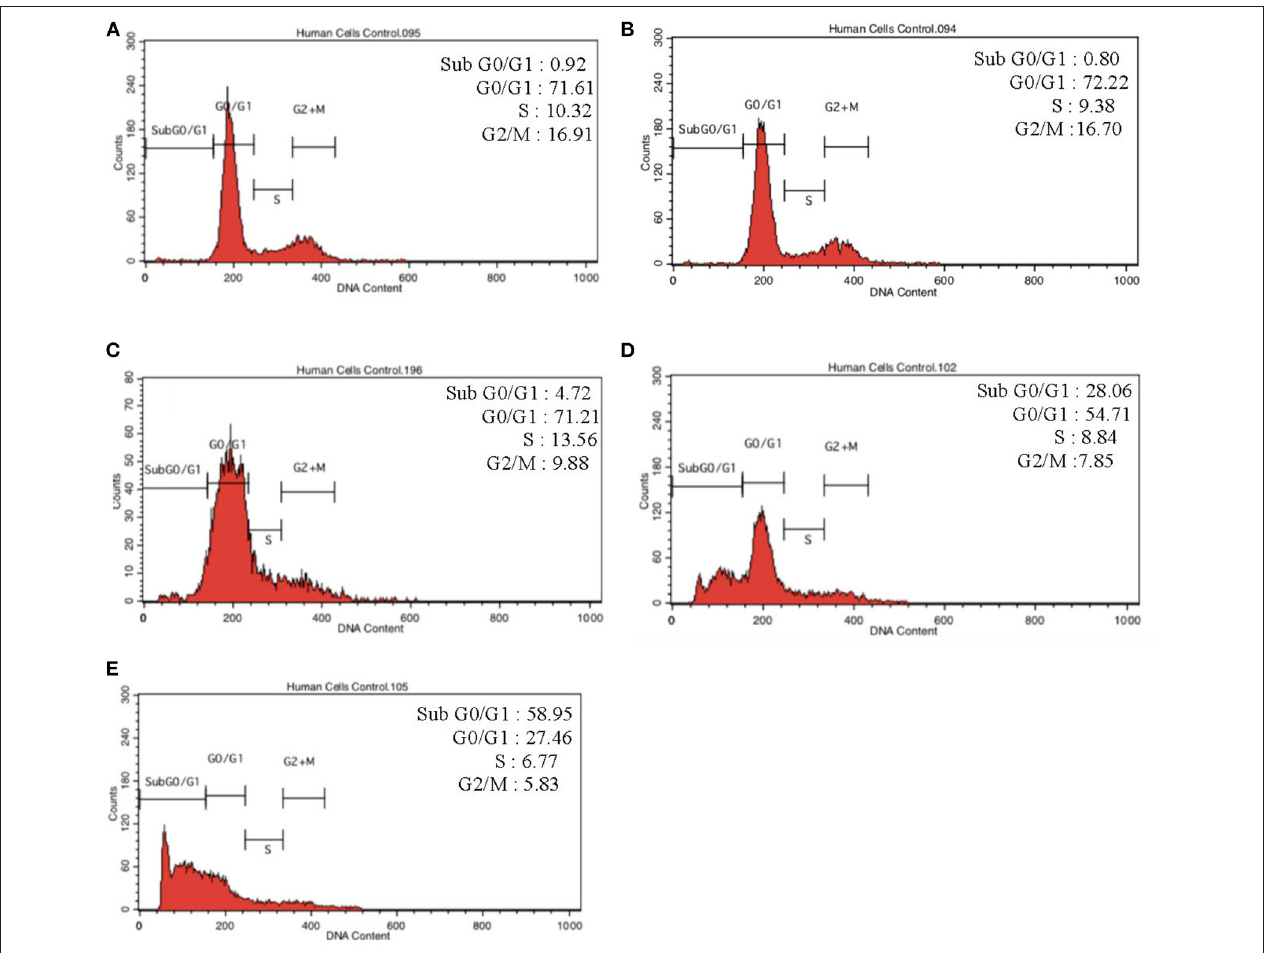
FIGURE 8 | Cell cycle distribution analysis in LPS-preconditioned cells by using flow cytometry. Cells were treated with 3 µ g/mL LPS for (A) . Control, (B) . 12, (C) . 24, (D) . 48, and (E) . 72h. Representative flow cytometry patterns from three independent experiments are shown.